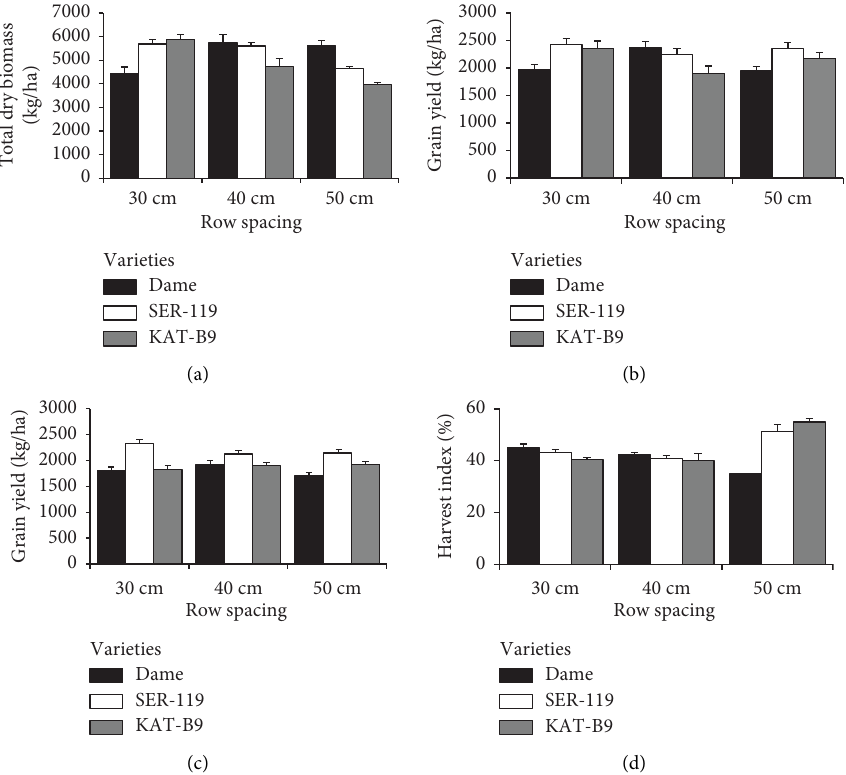
Figure 4: Interactive efect of inter-row spacing × variety on (a) total biomass at Arsi Negele; (b) grain yield at Arsi Negele; (c) grain yield at MARC; and (d) harvest index at Arsi